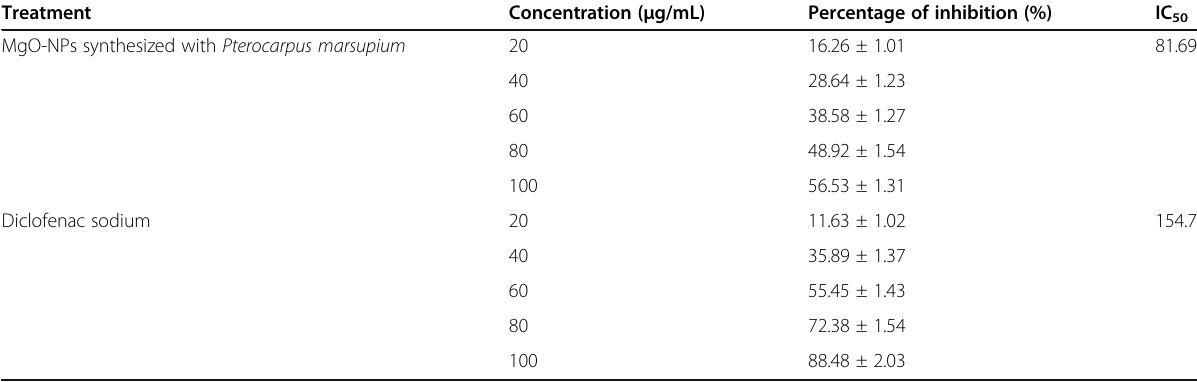
Values are expressed in terms of mean ± SEM ( n =